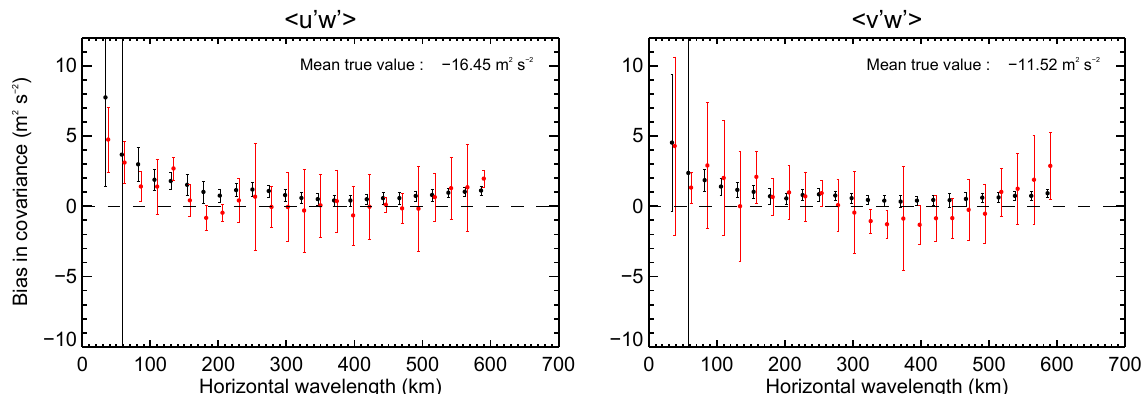
Figure 6. A comparison of the biases in the model covariance terms extracted from the 5BD (black) and VHF meteor radar (red) techniques, averaged over a 48h period, with individual bin widths (or integration times) of length 2h, for the single wave case. The error bars show the standard deviation in the bias determined over 200 realizations of the initial gravity wave phase/scattering position errors. −√ k 2 + l 2 , and k,l > 0) – i.e. (cid:104) u (cid:48) w (cid:48) (cid:105) , (cid:104) v (cid:48) w (cid:48) (cid:105) < (as m ∝